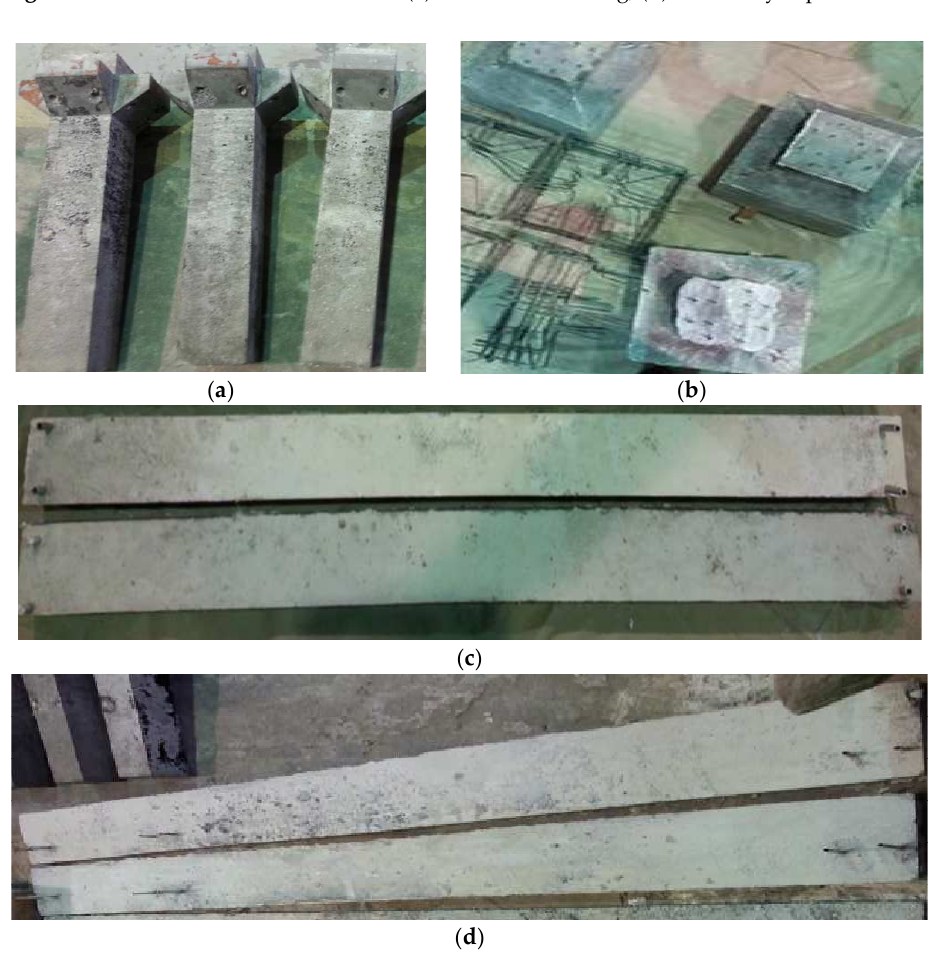
Figure 9. IBS components after casting: ( a ) columns; ( b ) hollow core footings; ( c ) beams; ( d ) slabs.